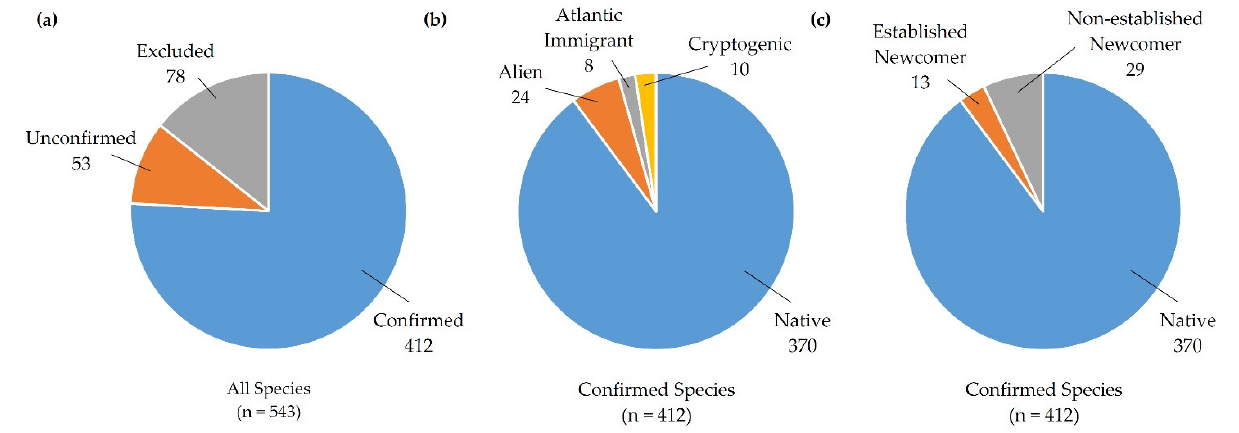
Figure 3. Categorization of fish species recorded from Maltese waters. ( a ) Number of fish species that are confirmed as occurring in Maltese waters, that may occur but are unconfirmed, and that should be excluded from the checklist of Maltese fish fauna; ( b ) Number of native and newcomer species confirmed as occurring in Maltese waters, with newcomers classified according to origin; ( c ) Number of native and newcomer species confirmed as occurring in Maltese waters, with newcomers classified according to establishment status.